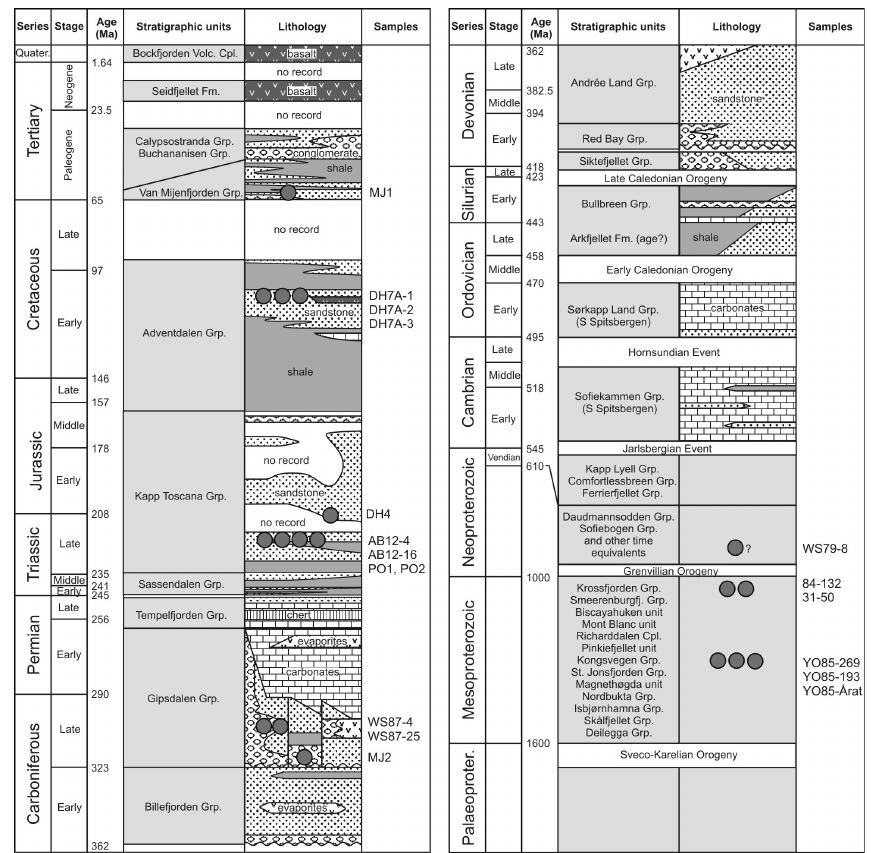
Fig. 7. Simplified geological timetable of Spitsbergen according to Dallmann (1999) and Dallmann et al. (2002) with stratigraphic positions of investigated onshore samples (dark